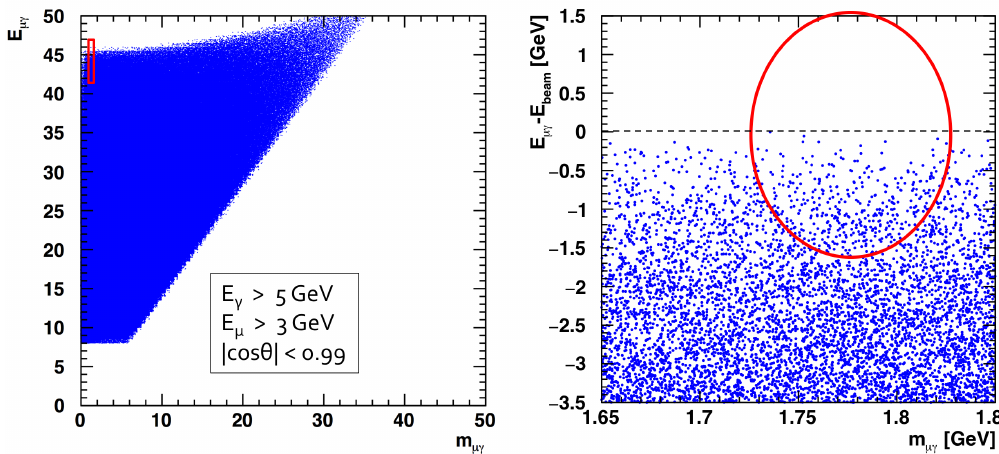
Figure 5: Main background to the τ → µγ search at FCC-ee. Reconstructed energy versus mass of all µγ combinations in simulated background events e + e − → Z → τ + τ − γ with one τ → µ ¯ νν decay. The right-hand diagram, showing an enlargement of the red boxed region from the left-hand diagram, has the signal region shown by a red